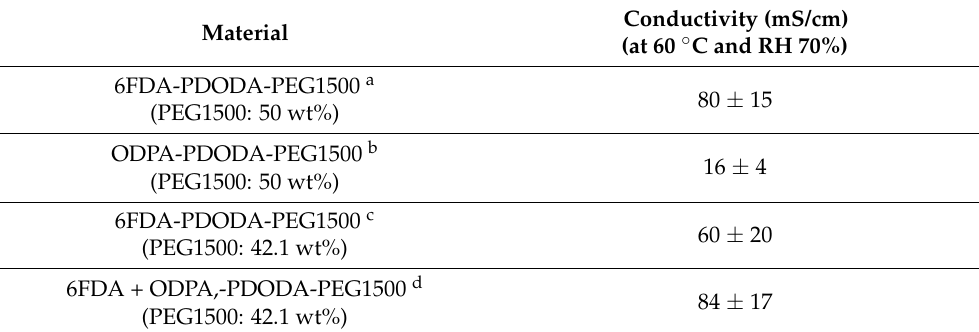
Table 5. Conductivity measurements of the EAN-doped SBC membranes (values are for the SBC membranes that are not thermally annealed. For detailed calculations please see Supplementary Table S1).